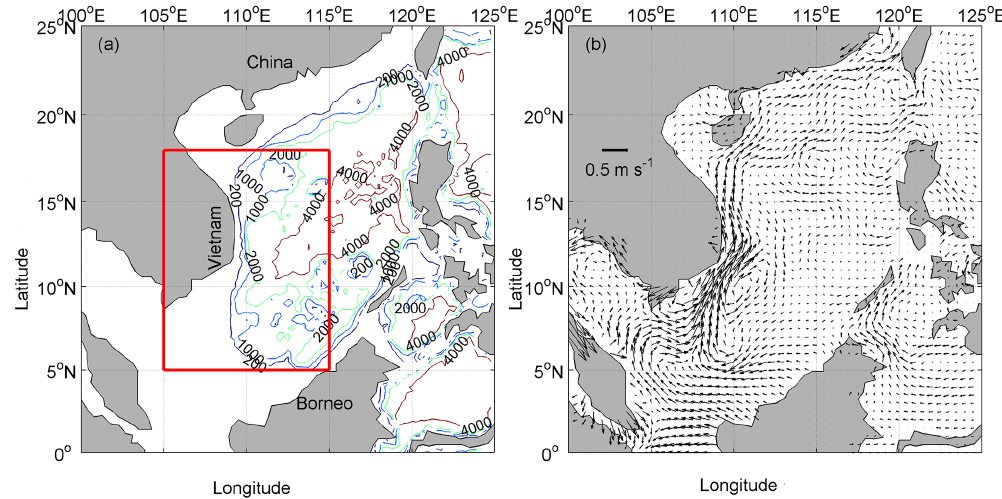
Figure 1. (a) Bathymetry of the South China Sea (m), the red rectangle represents the study area. (b) Mean surface geostrophic currents in June–October of 2002–2008. processes requires higher space–time resolution of ocean color